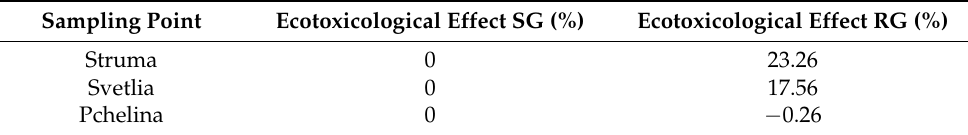
Table 4. Ecotoxicological studies using Phytotoxkit F ™ applied to the sediments from the three sampling